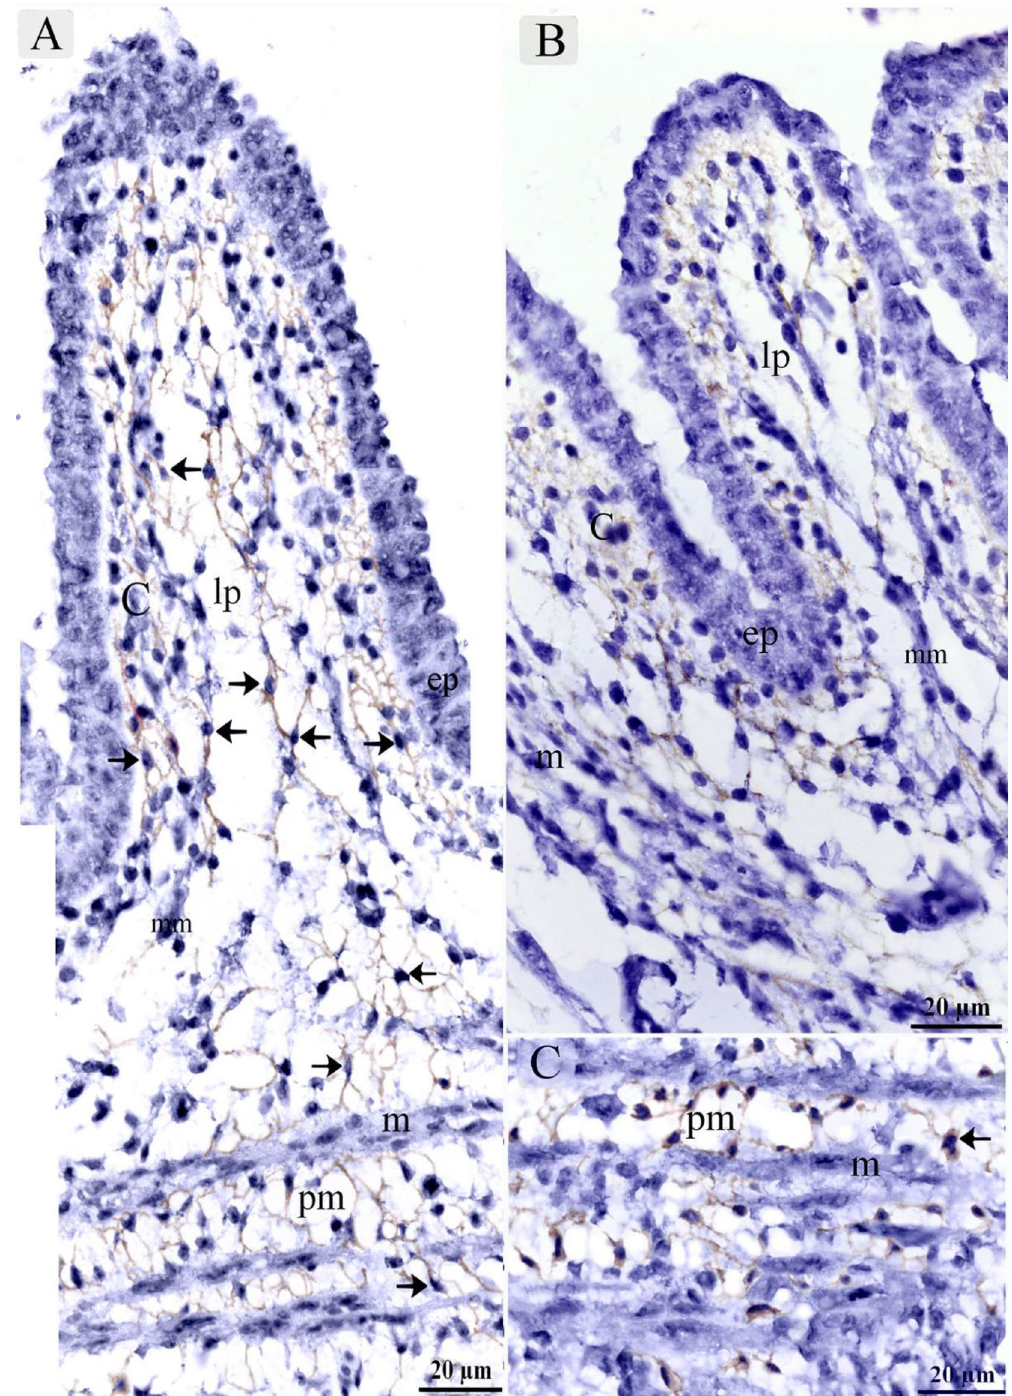
Figure 12. Immunohistochemical staining of the esophagus at day 8 using CD34 and VEGF. Immunostained paraffin sections of day 8 for CD34 ( A ) and VEGF ( B ). ( A ) Strong CD34 positive cells were identified in the condensed layer (c) of the lamina propria (lp) and peri-muscular tissue (pm). Strong CD34 positive TCs (arrows) were distinguished by cell prolongations (telopodes). Note muscle cells (m). ( B ) VEGF positive cells were identified in the lamina propria (lp) and peri-muscular tissue (pm). VEGF positive TCs (arrows) were distinguished by cell prolongations (telopodes). Note muscle cells